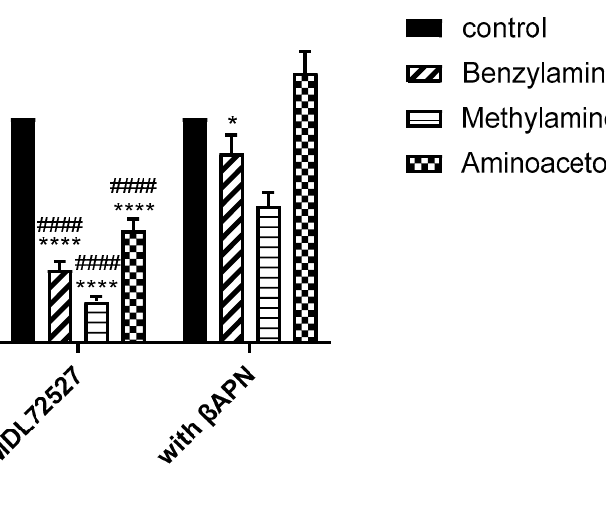
Figure 5. MDL72527 demonstrates stronger inhibitory potential over β APN in inhibiting SSAO driven ROS production in VSMCs. VSMCs were treated with different amines, benzylamine (500 µM), aminoacetone (45 µM) and methylamine (500 µM), and amines in the presence of inhibitors (100 µM MDL72527) and (200 µM β APN). In benzylamine-treated cells there was a significant difference in ROS production in cells without inhibitor and in the presence of MDL72527 and β APN (**** p < 0.0001 for MDL72527 vs. without inhibitor & * p < 0.05 for β APN vs. without inhibitor, two-way ANOVA followed by Tukey’s). In methylamine- and aminoacetone-treated cells there was a significant difference in ROS production in cells without inhibitor and in the presence of MDL72527 (**** p < 0.0001 for MDL72527 vs. without inhibitor, two-way ANOVA followed by Tukey’s). There was no statistical difference ( p > 0.05) in ROS production in methylamine- and aminoacetone-treated cells without inhibitor and in the presence of β APN. Additionally, significant difference in ROS production was detected between MDL72527 and β APN in benzylamine, methylamine- and aminoacetone-treated cells ( #### p < 0.0001 for MDL72527 vs. β APN, two-way ANOVA followed by Tukey’s). The asterisk (*) indicates statistical difference between cells without inhibitor and cells treated with MDL72527 or β APN. The hash ( # ) indicates statistical difference between MDL72527 and β APN for each amine. Values are mean ± S.E.M. (n = 5).